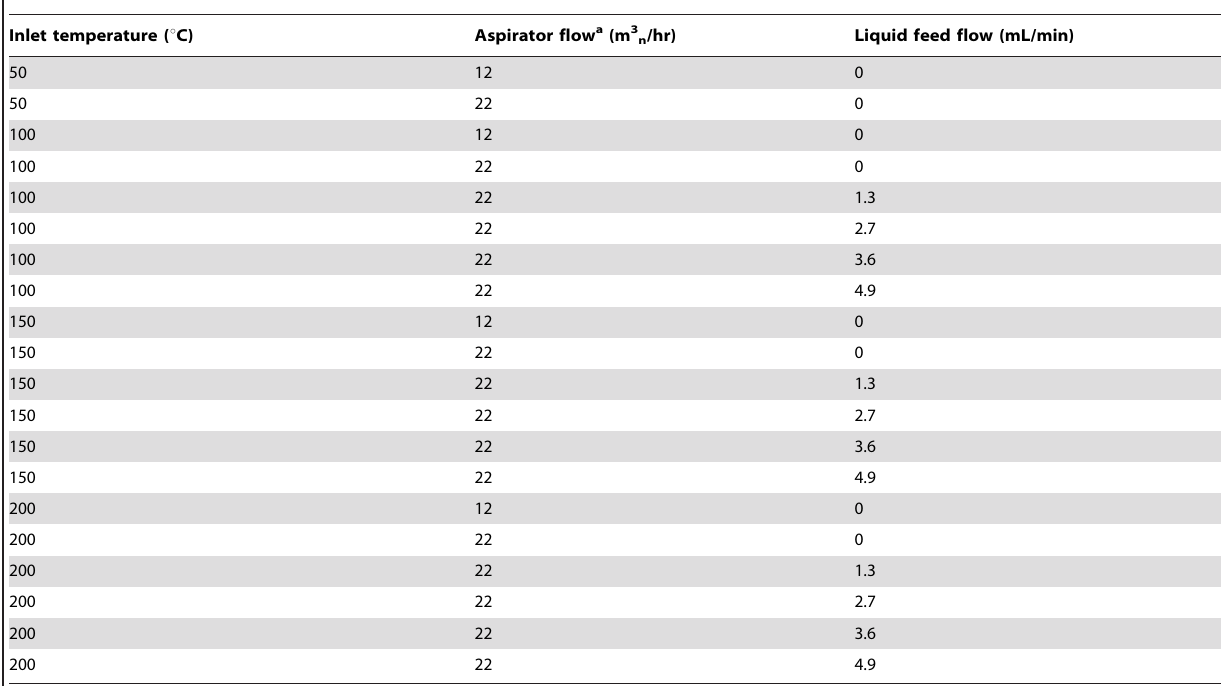
Table 1. Spray dryer settings used for model fitting and validation.